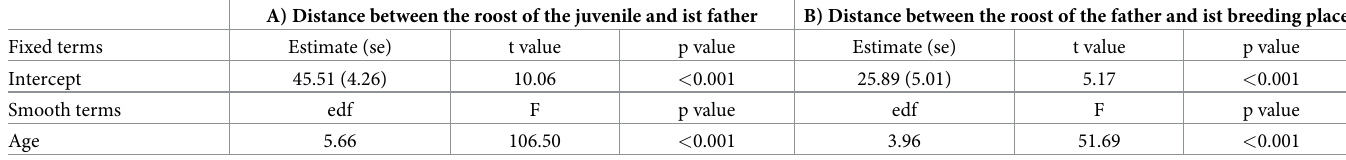
juveniles ( β = -1.4 ± 0.6 SE, z = -2.22, p = 0.026, Fig 8). Five juveniles died after collision with a car or power line (2 cort-, and 3 placebo individuals), one placebo-individual died in a slurry- tank, one cort-individual in a ventilation shaft. From ten we only found remains (feathers, car- casses) and could not determine the cause of death. Table 3. Results of a generalized additive mixed effect model (GAMM) with A) Distances between fathers and their offspring in relation to offspring age and B) Dis- tance between fathers and their rearing nest boxes in relation to offspring age as dependent variables. A) Distance between the roost of the juvenile and ist father B) Distance between the roost of the father and ist breeding